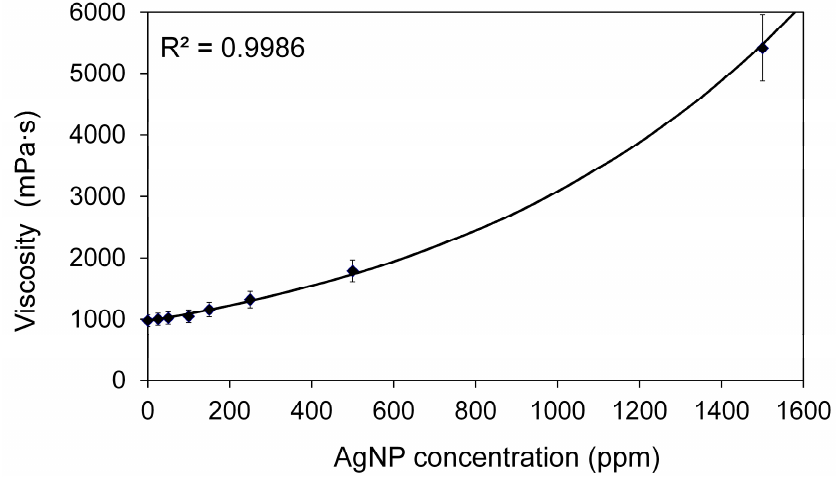
Figure 1. The relationship between viscosity and AgNP concentration in Bis-GMA/TEGDMA/AgNP compositions. All results were statistically significant ( p < 0.05).